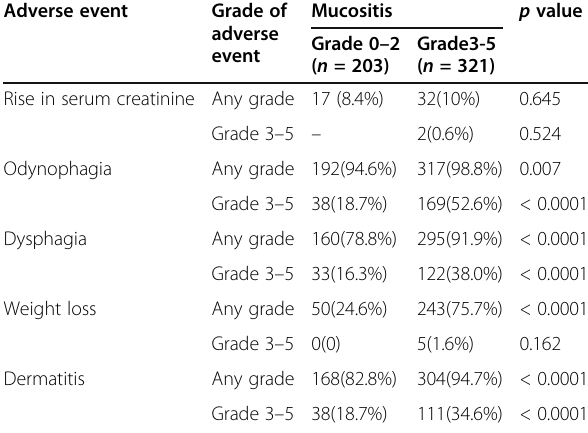
Table 3 Association of acute oral mucositis with other toxicities Adverse